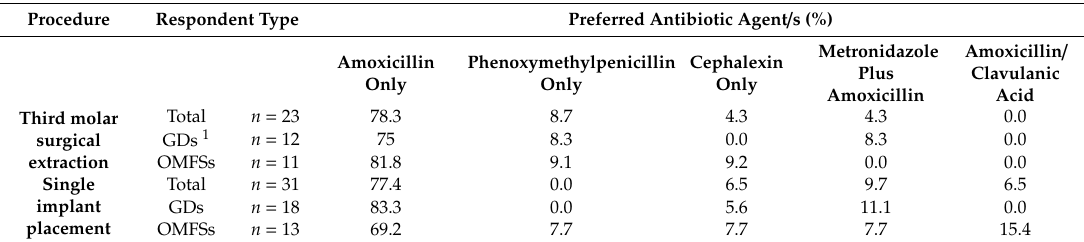
Table 4. Preferred antibiotic agent / s of practitioners who prescribed antibiotics 1 .